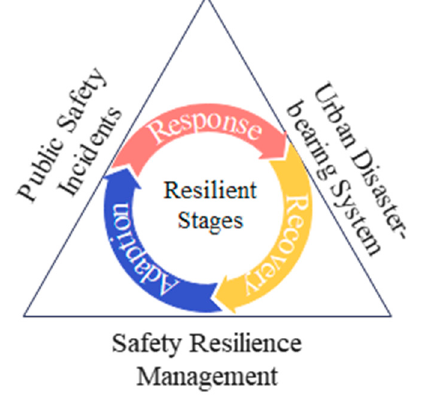
Figure 1. Triangle theoretical model of urban safety resilience.